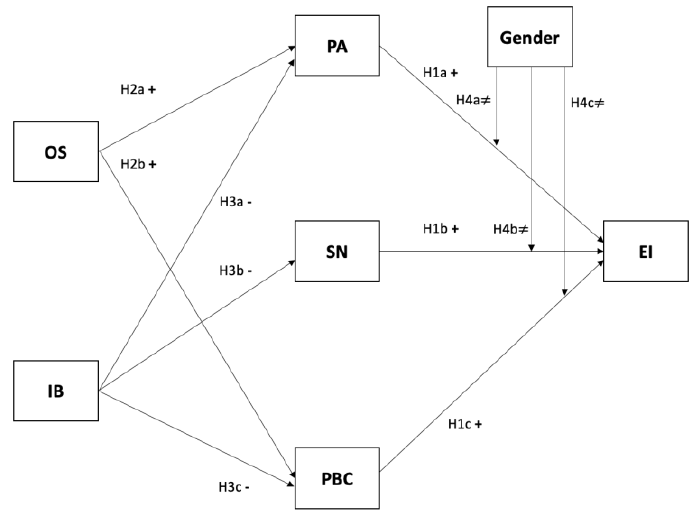
Figure 1. Research model and hypotheses .